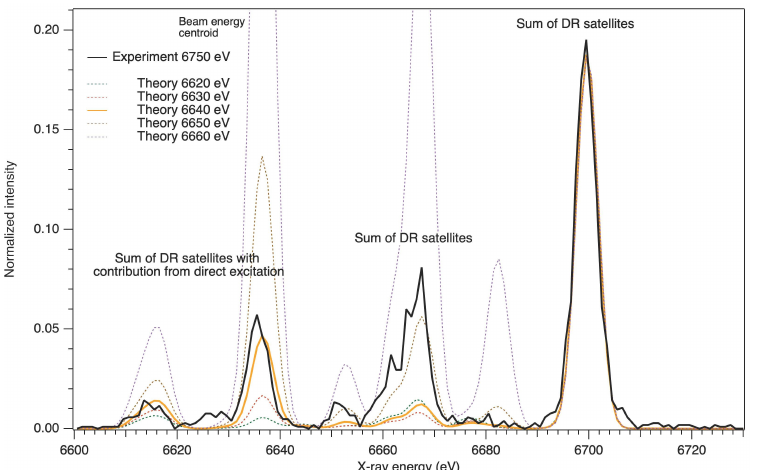
Figure 4. Comparison of normalized measured and theoretical spectra of Fe ions at a nominal experimental beam energy of 6750 eV. The observed spectrum is shown by a solid black line and the theoretical spectrum that corresponds to the best match is shown by a solid orange